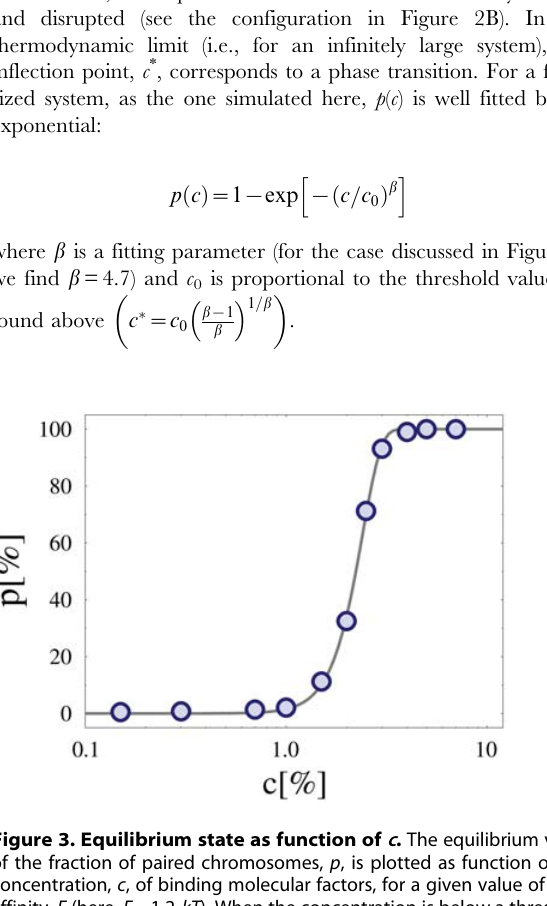
Figure 4. Phase diagram. The diagram shows the thermodynamic equilibrium state of the system in the ( E , c ) plane, for a range of typical biochemical binding energies, E , and concentrations, c . Circles mark the line c * ( E ) delimiting the transition from the Brownian phase, where chromosomes diffuse independently, to the Pairing phase, where chromosomes are juxtaposed (the superimposed fit is a power law).